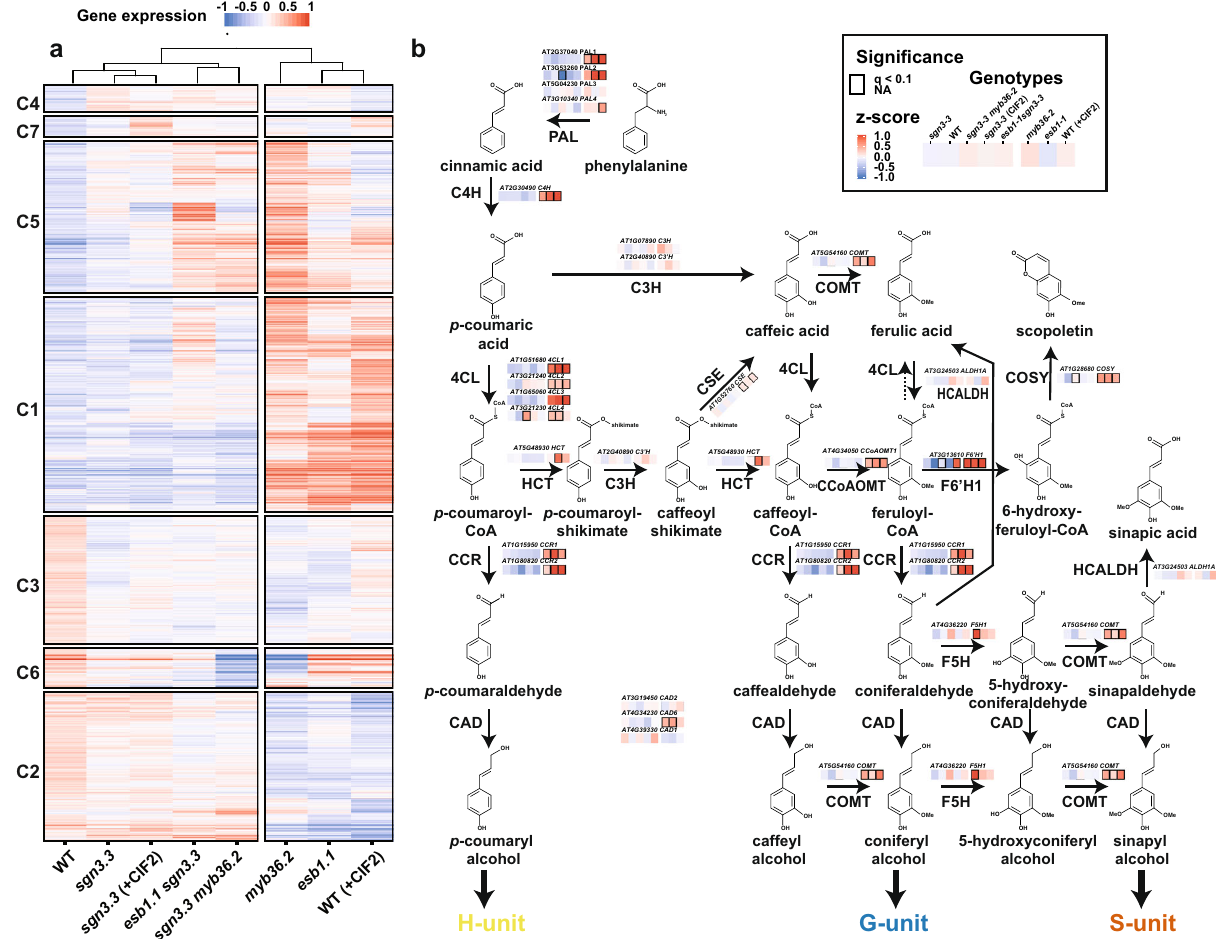
Fig. 3 Modulation of the phenylpropanoid pathway by the Schengen-pathway. a Heatmap of the 3564 differentially expressed genes identi fi ed in the RNA- seq in root tips of wild-type (WT), sgn3-3 , esb1-1 , myb36-2 , esb1-1 sgn3-3 , sgn3-3 myb36-2 plants. Treatment with 100 nM CIF2 was applied as indicated ( + CIF2) for WT and sgn3-3 plants. Clusters (C) are designated with numbers ( n = 7). Genes belonging to each cluster are listed in Supplementary Data 1. b Phenylpropanoid pathway leading to the lignin monomers and scopoletin biosynthesis (adapted from 72 ). Solid arrows represent enzymatic steps. Gene expression from the genes selected in Supplementary Fig. 3d was mapped on the pathway according to their KEGG enzyme nomenclature. Only the genes with a demonstrated function in lignin biosynthesis as listed in Supplementary Fig. 3d were mapped. PAL PHENYLALANINE